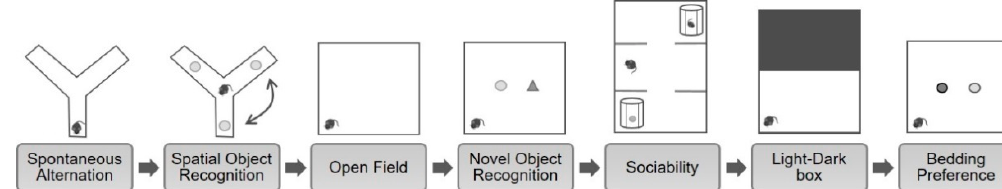
Figure 5. Schematic of the behavioral battery. This battery comprises a comprehensive behavioral battery to investigate multiple behavioral domains. In chronological order the battery consists of spontaneous alternation behavior in the Y-maze (working memory), spatial object recognition task (spatial memory), open field (locomotor activity), novel object recognition task (episodic memory), sociability test (social preference), light-dark box (anxiety-like behavior), and bedding preference task (olfaction) with 15 min of inter-test intervals.